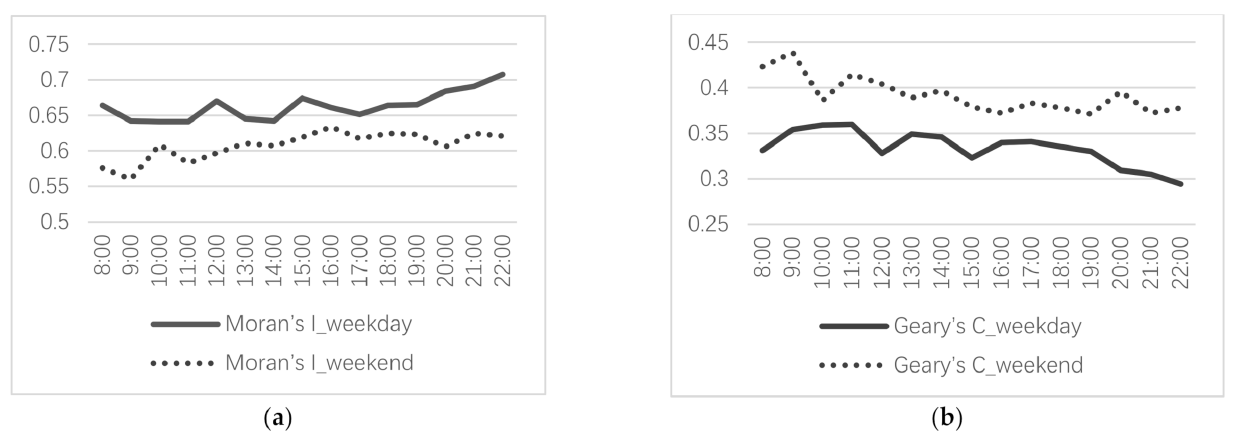
Figure 6. Results of the spatial correlation tests: ( a ) Moran’s I on weekday and weekend; ( b ) Geary’s C on weekday and